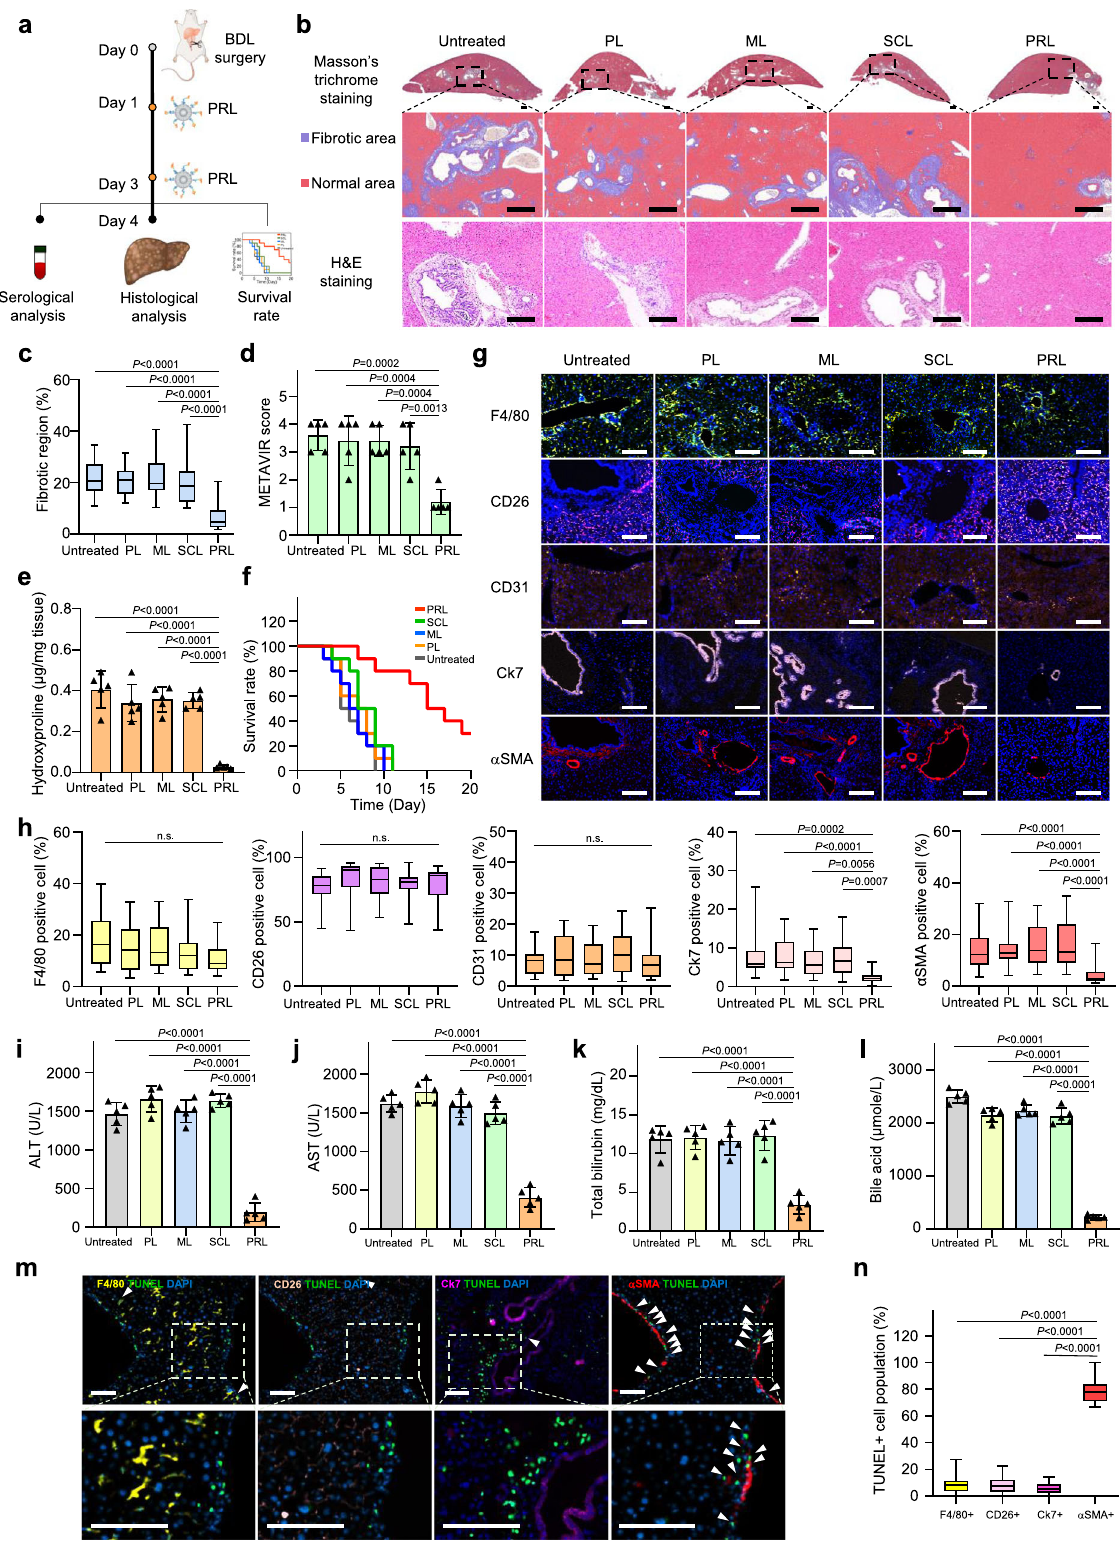
hypothesized that progressed fi brosis would activate the anti- fi brotic effect of PRL more effectively than early-phase fi brosis. Indeed, we observed that the anti fi brotic effect of PRL was less intense when PRL was given at week 4 of CCl 4 treatment com- pared to the utilized regimen of starting at week 6 of CCl 4 induction (Supplementary Fig. 7). The increased effect of